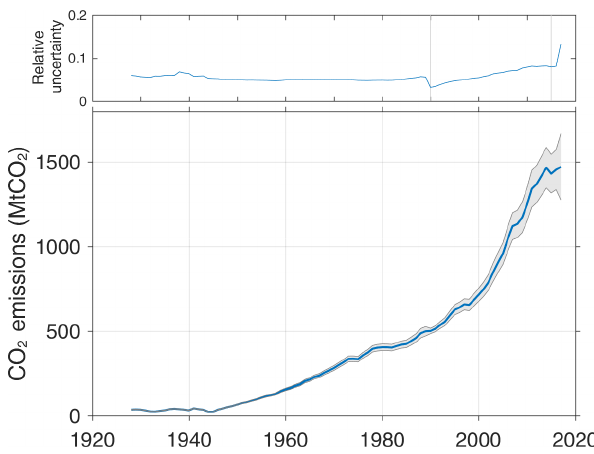
Figure 2. Global process emissions from cement production, with a 95% confidence interval. A step change in uncertainty occurs in 1990, reflecting a significant change in data